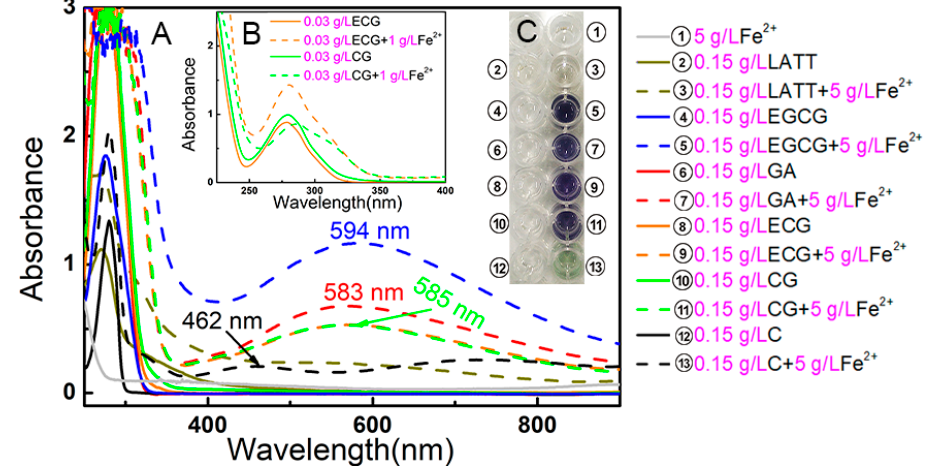
Figure 4. ( A ) UV spectra of Fe 2+ -chelating complex; ( B ) UV-visible spectra of ECG and CG in Fe 2+ -chelating reaction; ( C ) Appearance of solutions.